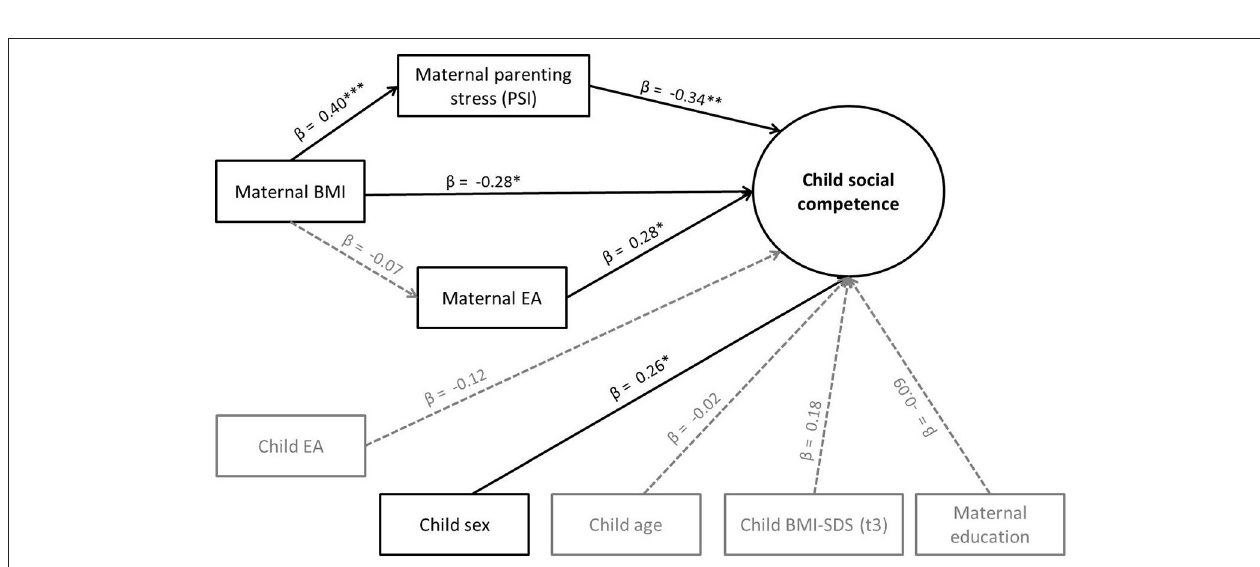
FIGURE 2 | Moderation effect of maternal EA on the relationship between maternal BMI and children’s social competence (Model 2b).